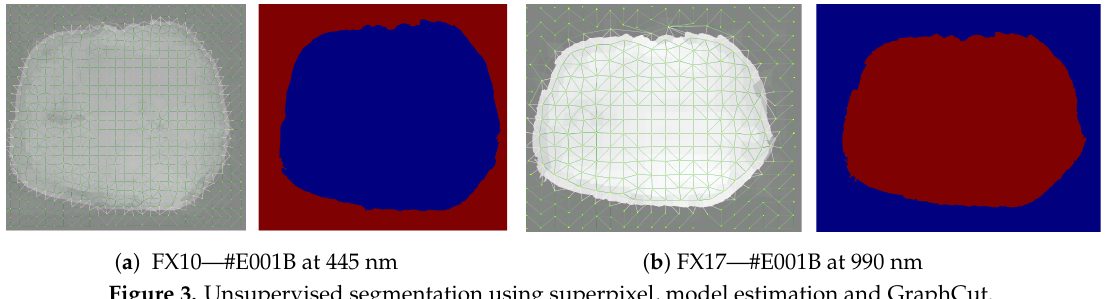
Figure 3. Unsupervised segmentation using superpixel, model estimation and